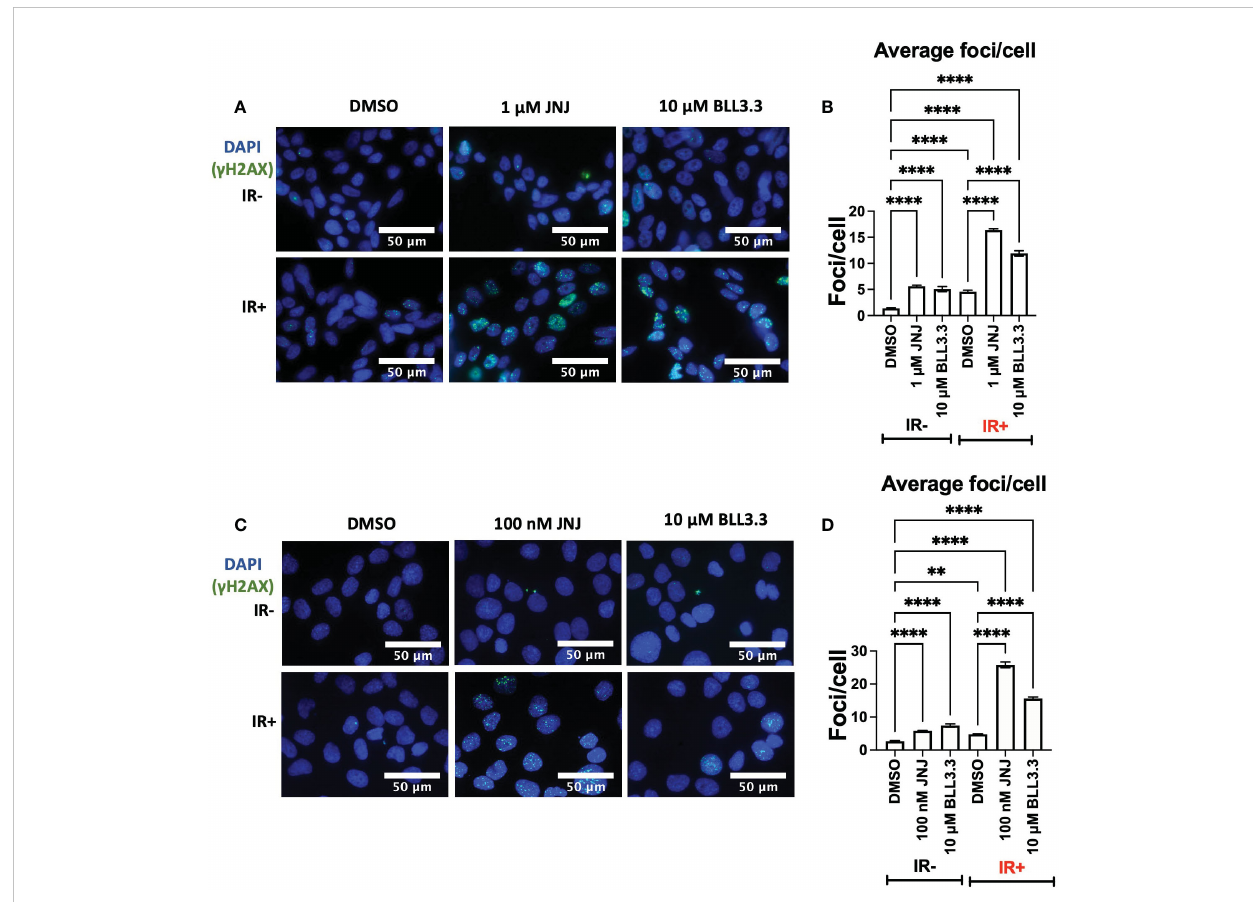
FIGURE 1 JNJ-64619178 hinders the radiation-induced damaged DNA repair in prostate cancer cells. (A) Representative fl uorescence immunocytochemistry images showing double-stranded DNA breaks ( g H2AX foci) images post 6hrs of 2Gy IR in LNCaP Cells. (B) Quanti fi cation of average DNA breaks per cell from (A, C) Representative fl uorescence immunocytochemistry images showing double-stranded DNA breaks ( g H2AX foci) images post 6hrs of 2Gy IR in DU145 Cells. (D) Quanti fi cation of average DNA breaks per cell from (B) For statistical analysis one-way ANOVA was performed with the Tukey test for multiple analysis, each bar in B, D are mean of SD of n=3 independent experiments (*P ≤ 0.05; **P ≤ 0.01; ***P ≤ 0.001; ****P ≤ 0.0001; NS, P >